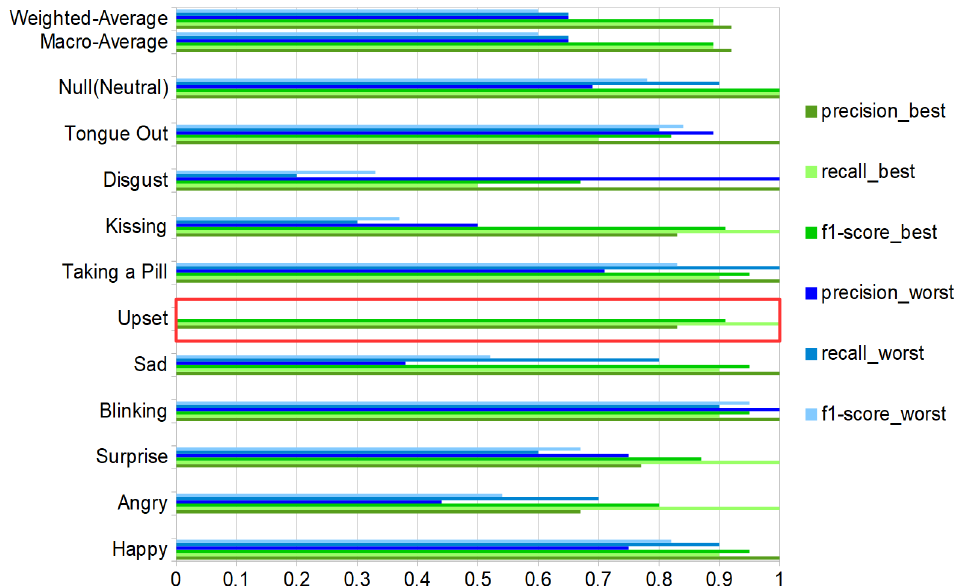
Figure 13. Best (green bars) and worst (blue bars) volunteer classification results for the ten activities and the null-class, with precision, recall and f1-score. The red box shows the upset expression with evaluation metrics equal to zero values for the worst case. Results with total test-events = 110 (10 per class, counting